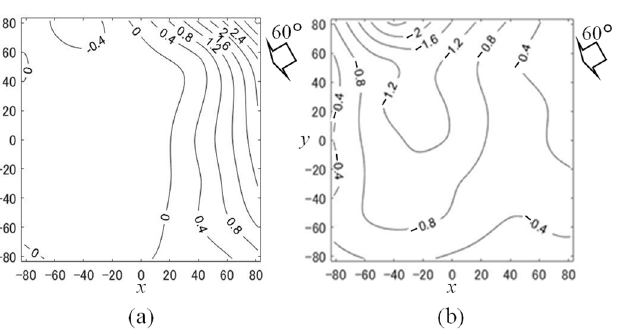
Figure 13. Contours of the maximum and minimum peak wind force coefficients at θ = 45°: ( a ) Maximum; ( b ) minimum.